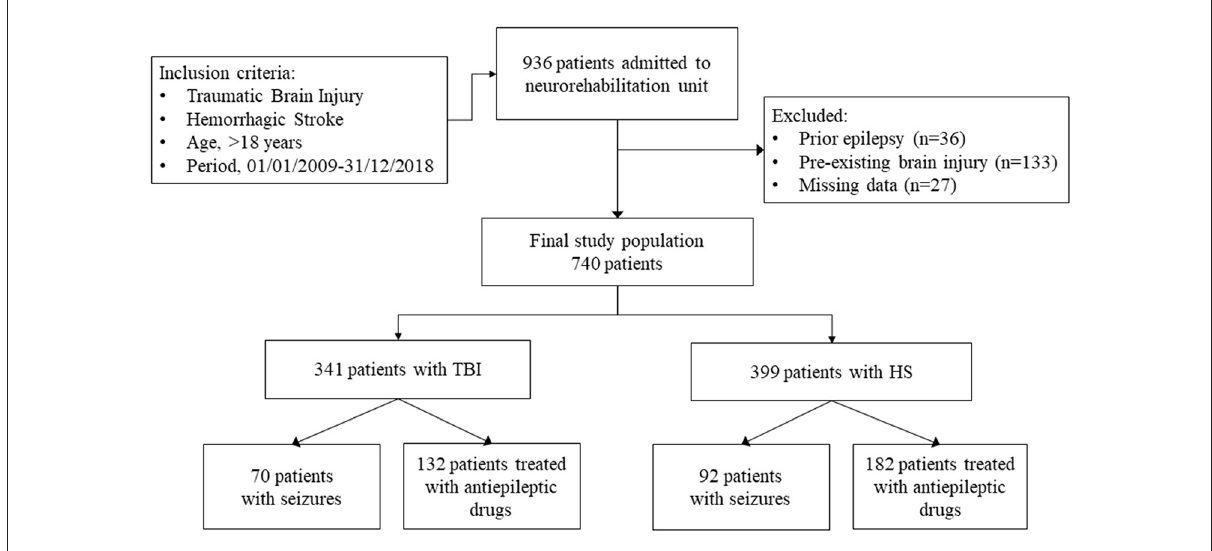
FIGURE1 Flow diagram of patients with acquired brain injury enrolled in the study.